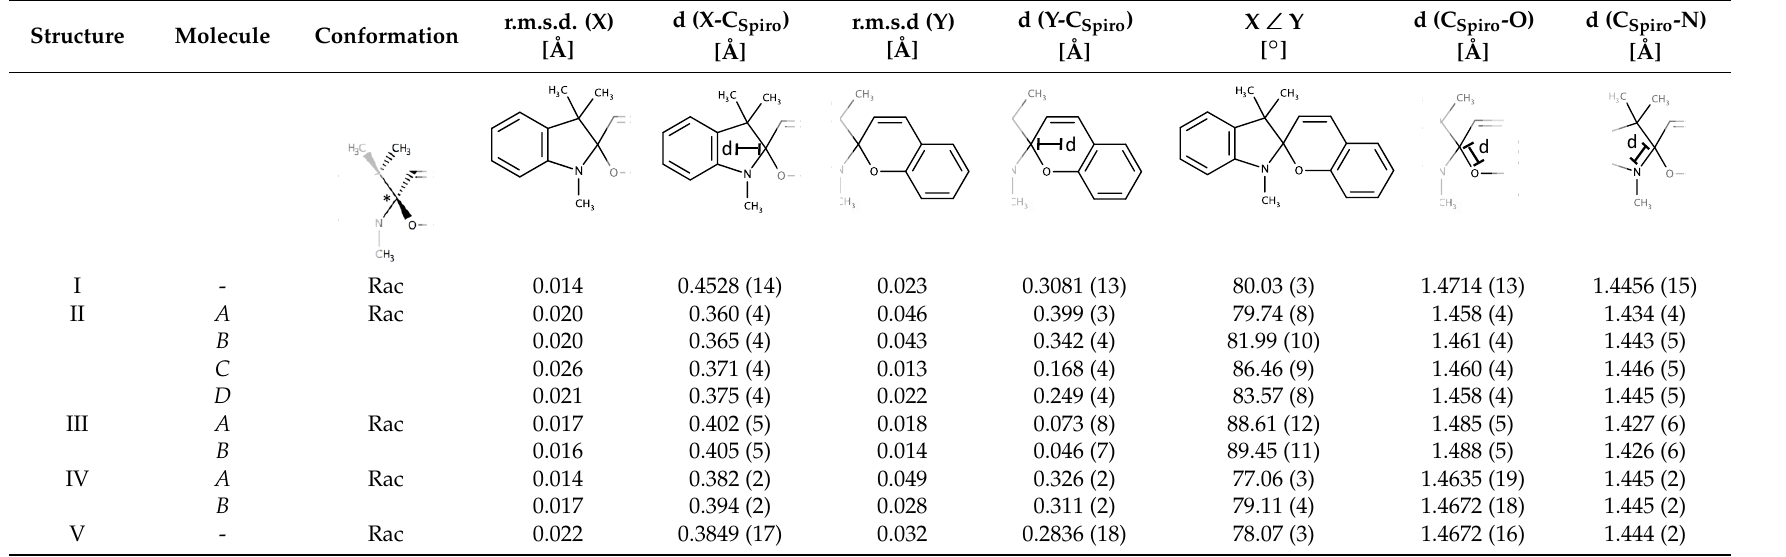
Table A1. Summary table of information given about the crystal structures in the main text.